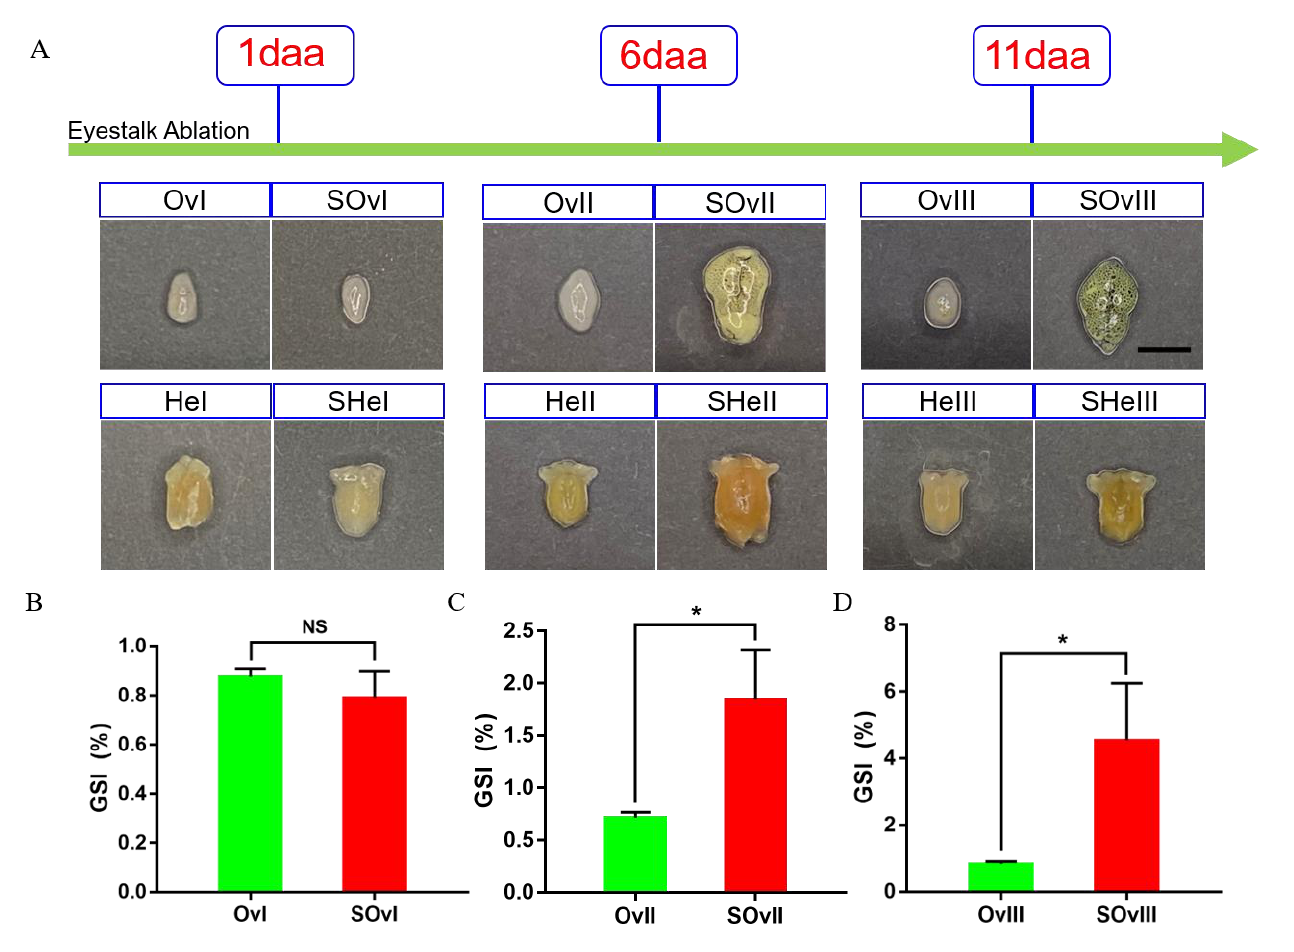
Figure 1. Development of the ovary and the hepatopancreas after unilateral eyestalk ablation in E. carinicauda . ( A ) Ovaries and hepatopancreases at different timepoints (scale, 500 µ m). ( B ) Gonadosomatic index (GSI) of E. carinicauda at 1 day, ( C ) 6 days, and ( D ) 11 days after eyestalk ablation (NS: no significance, * p < 0.05). The experimental groups of ovaries include SOvI , SOvII and SOvIII , which means the ovary sample at 1 day, 6 days and 11 days after eyestalk ablation, respectively. The corresponding control groups at the same timepoint were marked as OvI , OvII and OvIII . The experimental groups of the hepatopancreas include SHeI , SHeII and SHeIII , which means the hepatopancreas sample at 1 day, 6 days and 11 days after eyestalk ablation, respectively. The corresponding control groups at the same timepoint were marked as HeI , HeII and HeIII . daa: days after eyestalk ablation.